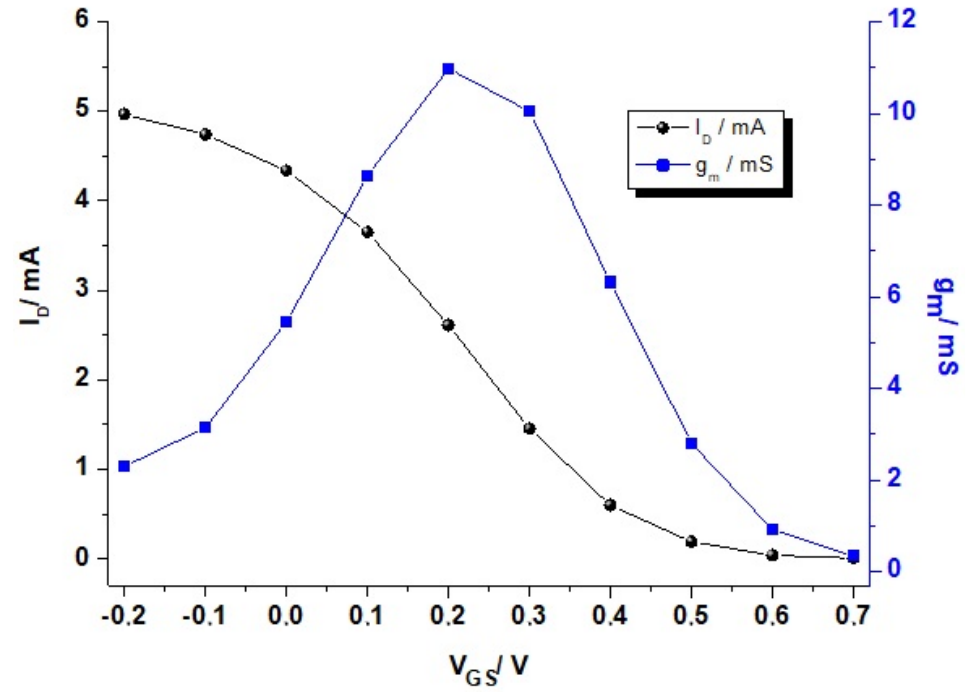
Figure 3. Representative transfer curve and transconductance ( g m ) of an OECT in depletion-mode operation. Black curve : Transfer curve (spheres dots) with an “on” state at V G = − 0.2–0 V and “off” state at V G = +0.5–0.6 V. Blue curve : Transconductance (square dots) of the transistor with maximum g m at +0.2 V. Conditions: V DS = − 0.4 V, material: PEDOT:PSS, dimensions: L = 1 µm, t = 100 nm.